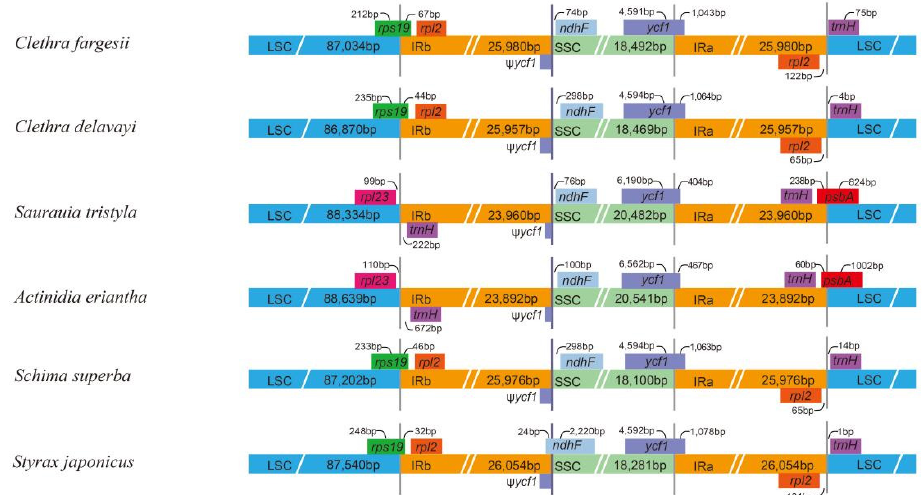
Figure 3. Comparison of the borders of large single-copy (LSC), small single-copy (SSC), and inverted repeat (IR) regions among six chloroplast genomes.